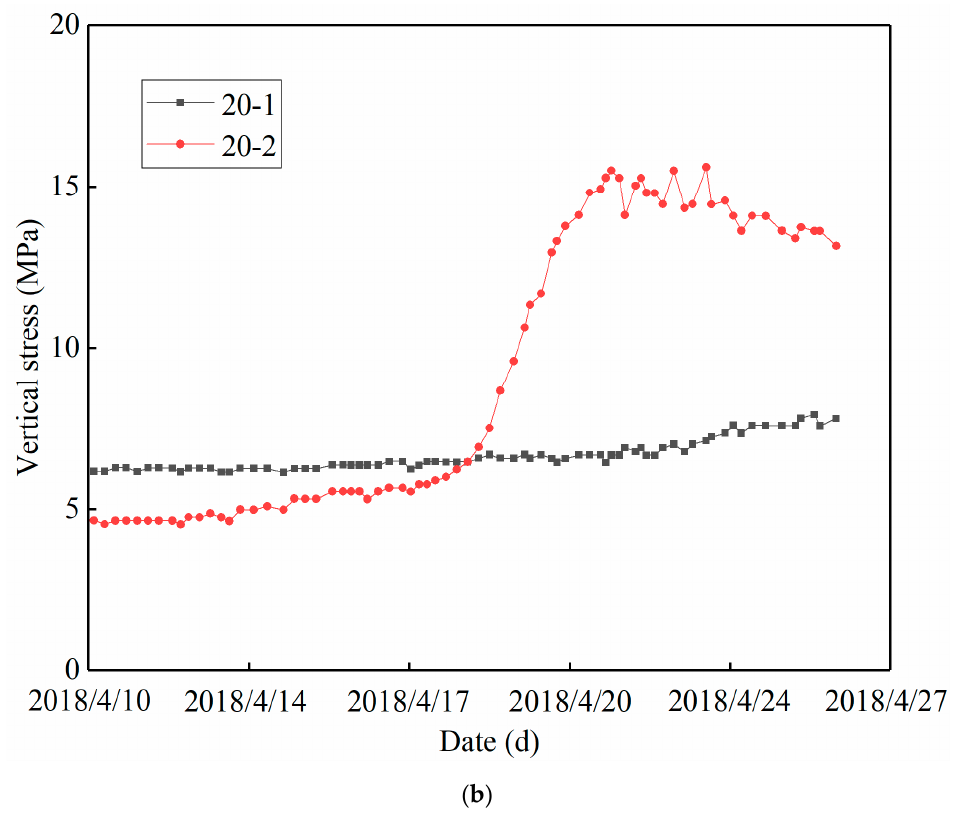
Figure 17. Relative vertical stress variation curve. ( a ) Relative vertical stress variation curve of station 3; ( b ) Relative vertical stress variation curve of station 20.